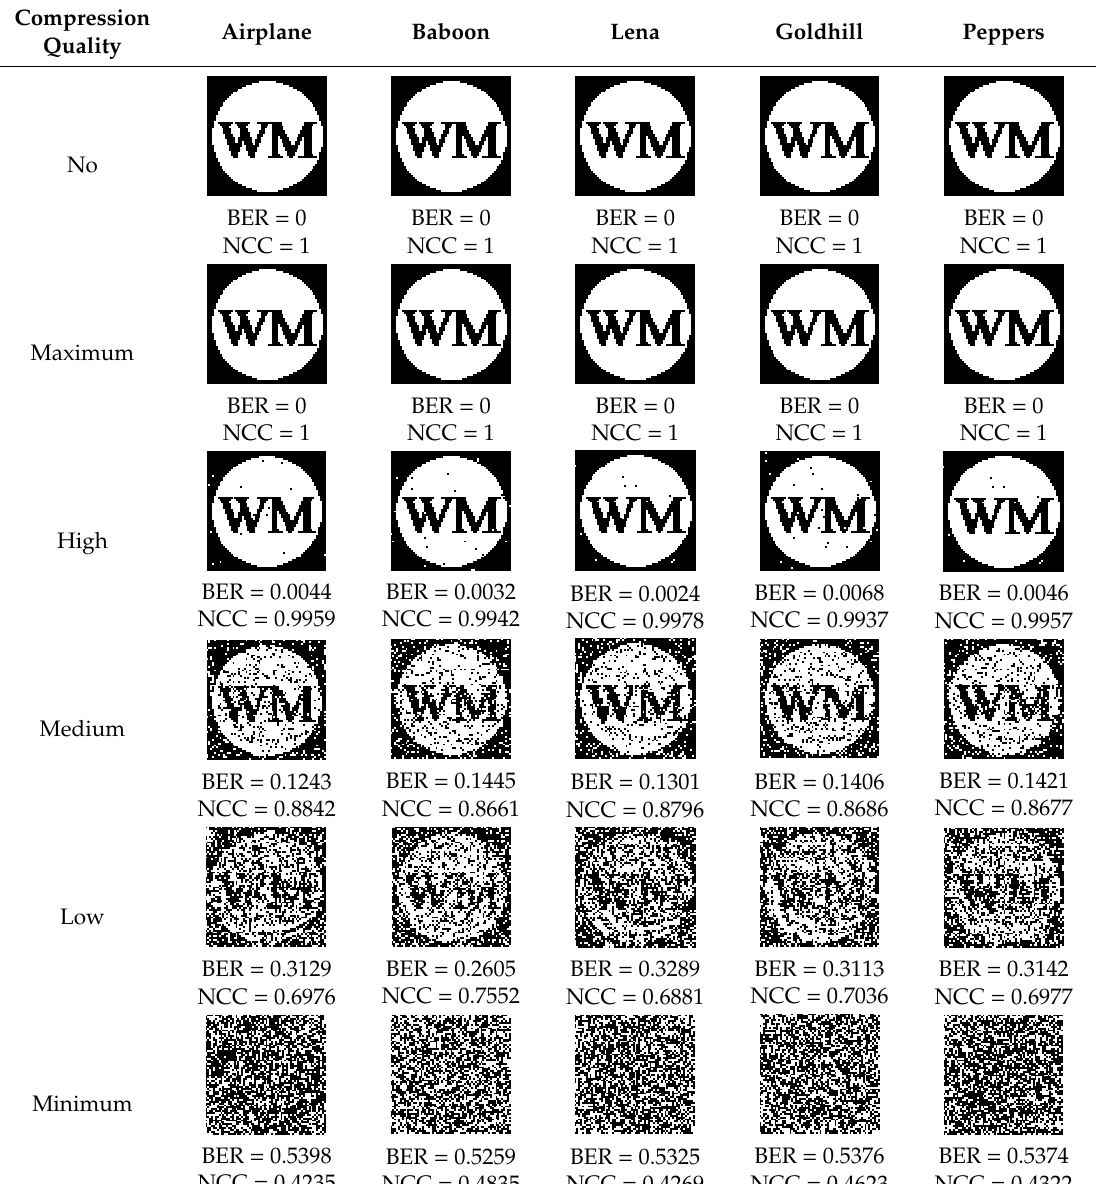
Table 4. Watermarks extracted from highly detailed watermarked images obtained by the algorithm in [34].